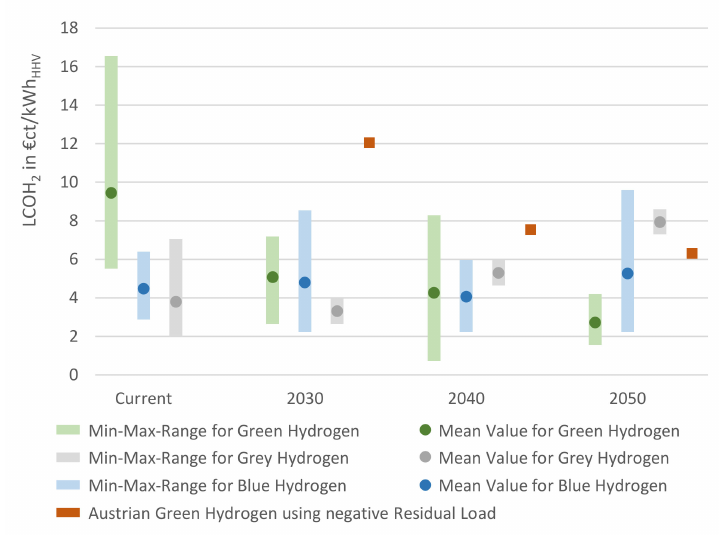
Figure 12. Literature overview of the development of hydrogen production costs over time. Green, blue and grey bars represent green, blue and grey hydrogen, respectively. All bars show the range in the literature between the minimum and maximum values. The dots represent the arithmetic mean. Blue and grey hydrogen include CO 2 emission costs. All values and corresponding sources can be found in Table 6. For comparison, the Austrian averaged LCOH 2 (determined in this study) are indicated by red